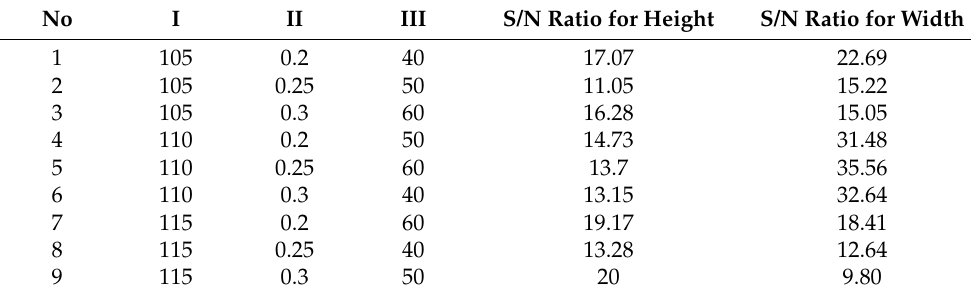
Table 5. Calculated S/N ratio